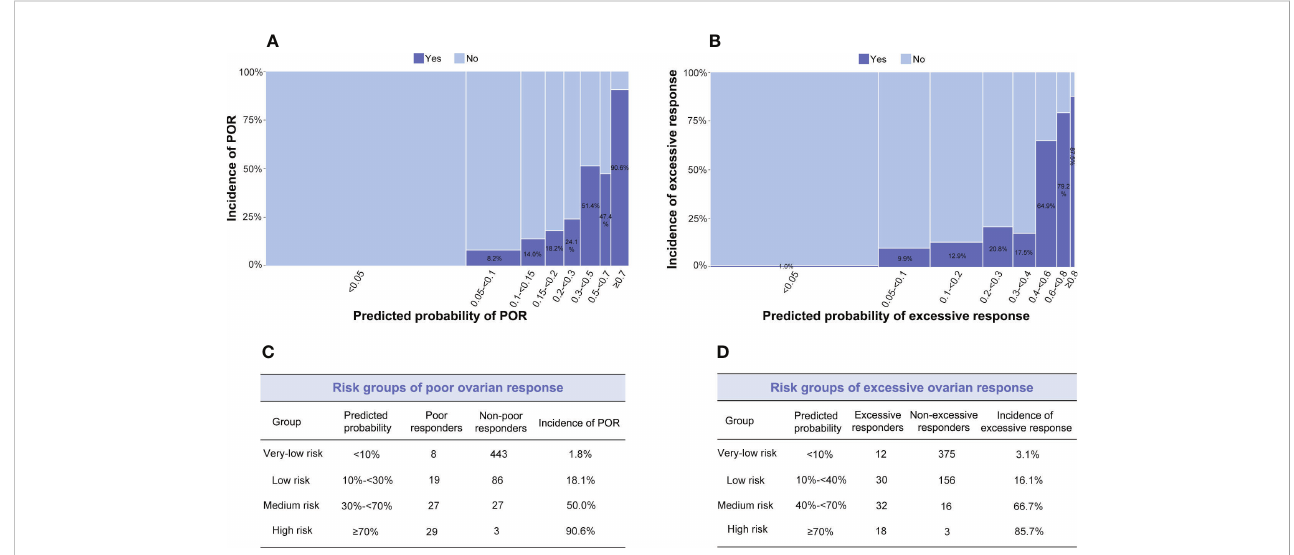
FIGURE 3 (A, B) Distribution between observed and predicted incidences of poor ovarian response (POR) (Model 1) and excessive ovarian response (Model 2s). The ordinate signi fi es the incidence, and the abscissa indicates the predicted probability: the wider the abscissa, the larger the sample size in each sub-group. (A) Light blue indicates the POR group; dark blue signi fi es the non-POR group. (B) Light blue indicates the excessive ovarian response group; dark blue signi fi es the non-excessive ovarian response group. (C) Risk groups of POR. (D) Risk groups of excessive ovarian response.